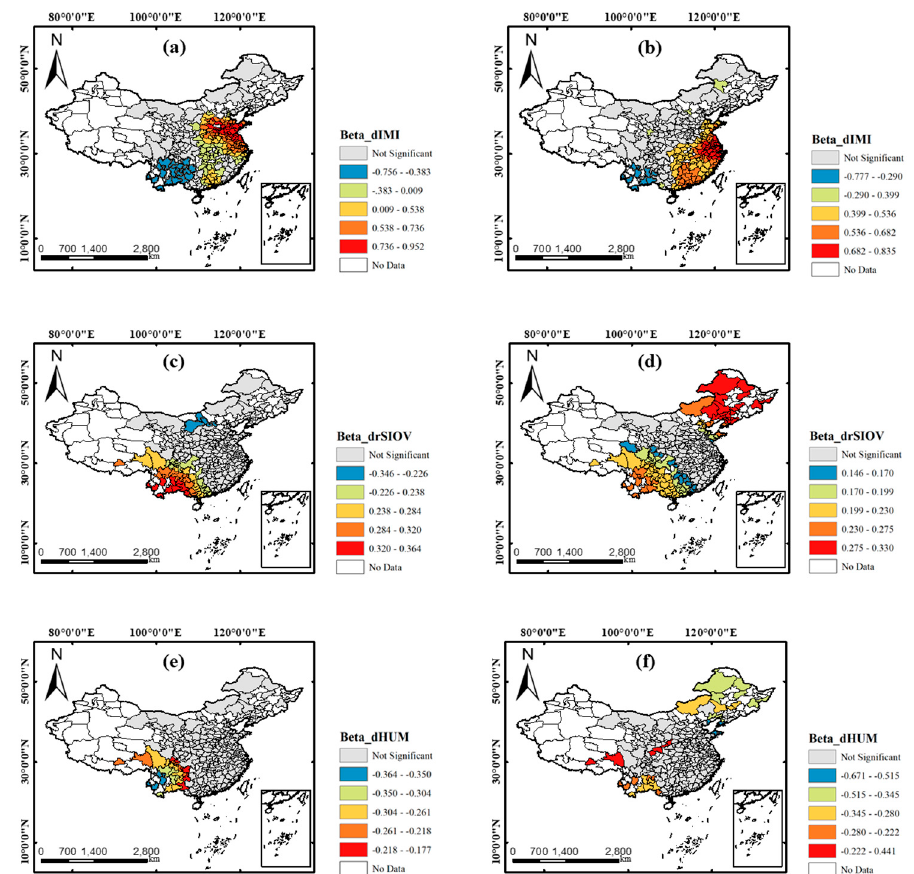
Figure 6. Spatial coefficients of decline of intra-city mobility intensity (dIMI) (( a ) for the PM 2.5 model and ( b ) for the PM 10 model), decline rates of the secondary industrial output values (drSIOV); (( c ) for the PM 2.5 model and ( d ) for the PM 10 model) and dHUM; (( e ) for the PM 2.5 model and ( f ) for the PM 10 model).